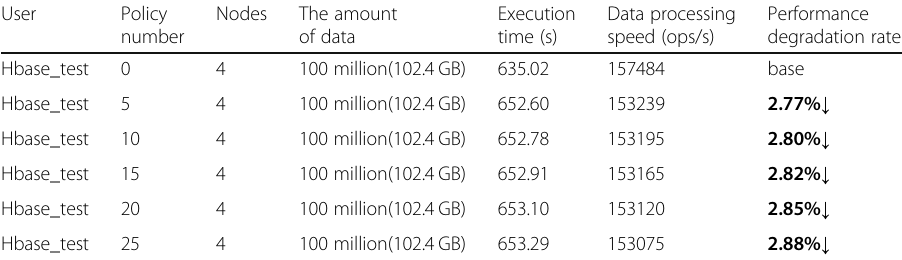
Table 6 Test results of different number of security policies using the new algorithm